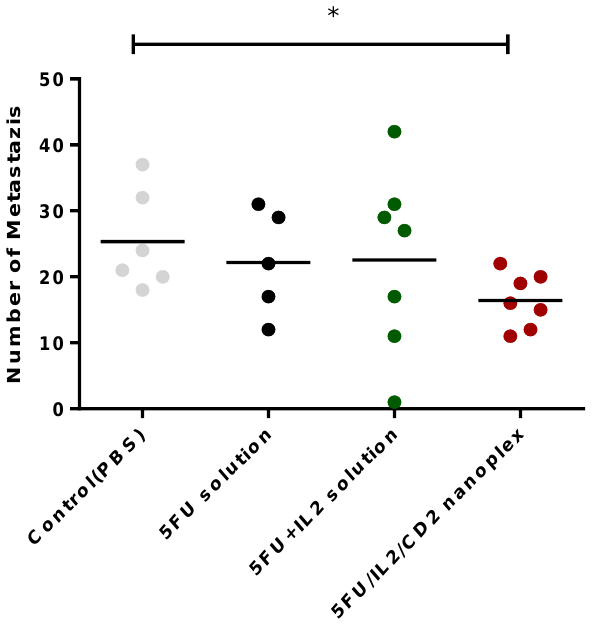
Figure 9. The number of metastasis foci in mice at the end of the treatment period (* p < 0.05).